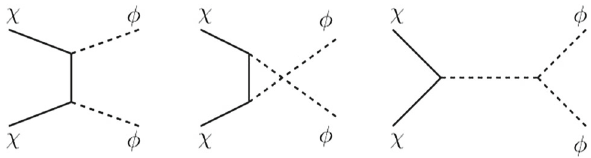
Fig. 1 Feynman diagrams of singlino annihilation to the scalars, with φ = H ,